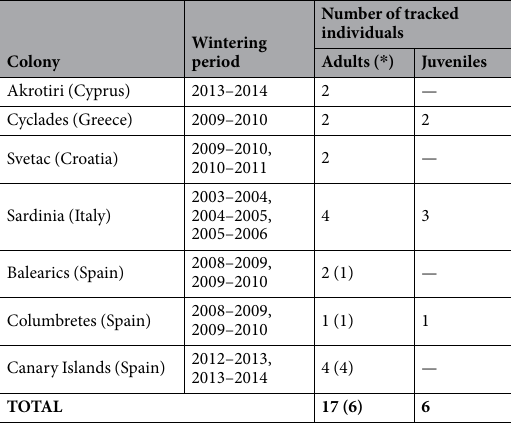
Table 2. Summary of satellite telemetry data for Eleonora’s falcon at its Malagassy wintering areas used in this study. * Number of individuals for which data were available from two consecutive wintering events and which fed the winter site-fidelity